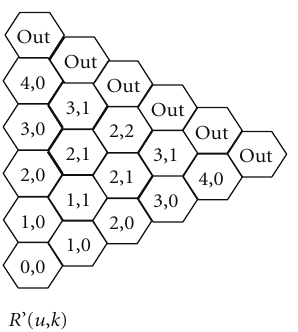
Figure 3: Simplified Moving Distance Model: R (cid:3) ( u , k ) .